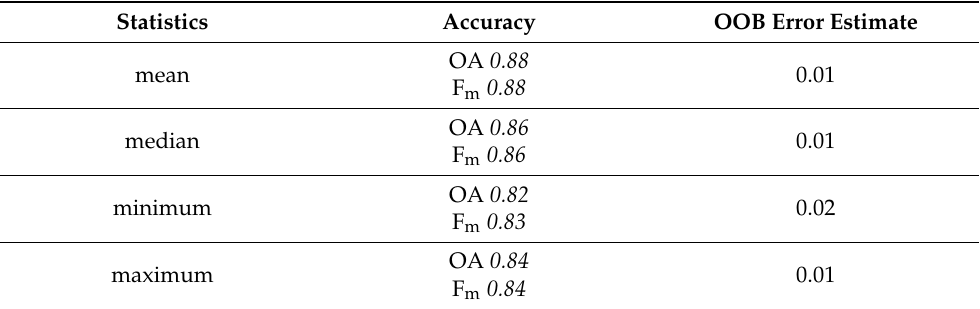
Table 4. The different combinations of bands adopted for the Su_IC input image with accuracy information of overall accuracy (OA) and multi-class F-score (F m ). Moreover, the out-of-bag (OOB) error estimate values for the RF algorithm are